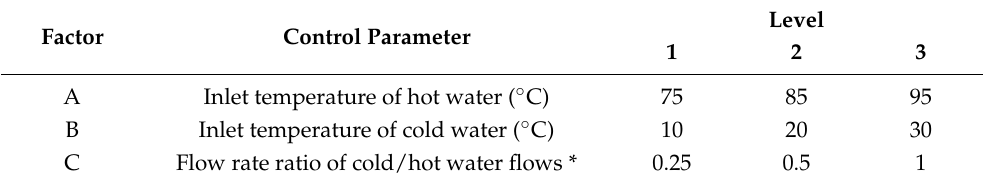
Table 2. Control factors and level settings for the Taguchi